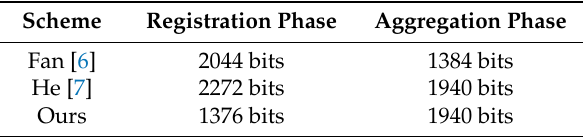
Table 12. Communication cost of the schemes.